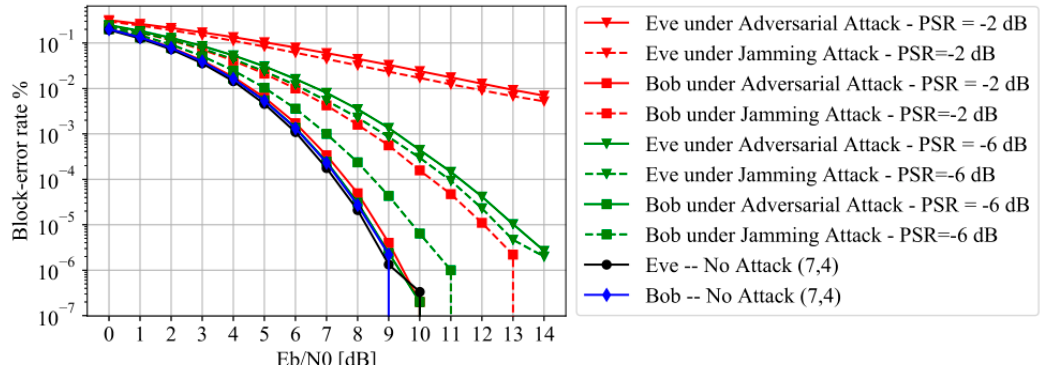
Figure 7. BLER versus E b / N 0 , the autoencoder-based wiretap channel under randomly shifted adversarial attack and artificial noise jamming assuming Bob employs the DNN network structure while Eve employs the CNN network structure.